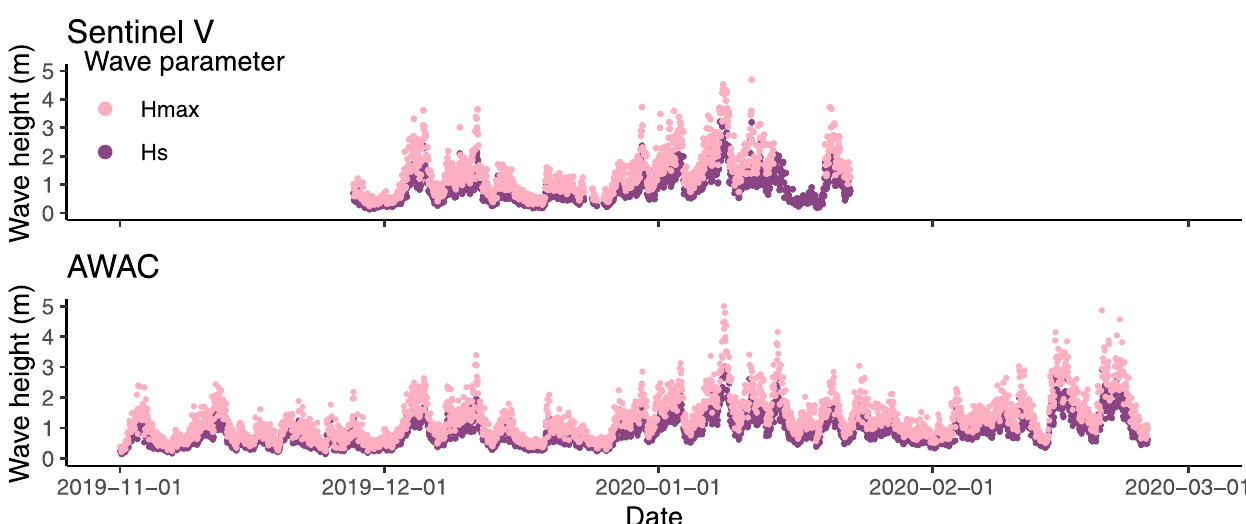
Fig 4. Wave height measured by two current profilers. The wave heights measured throughout the monitoring period. The Sentinel V was located south of the study cage whereas the AWAC was located north of the farm.